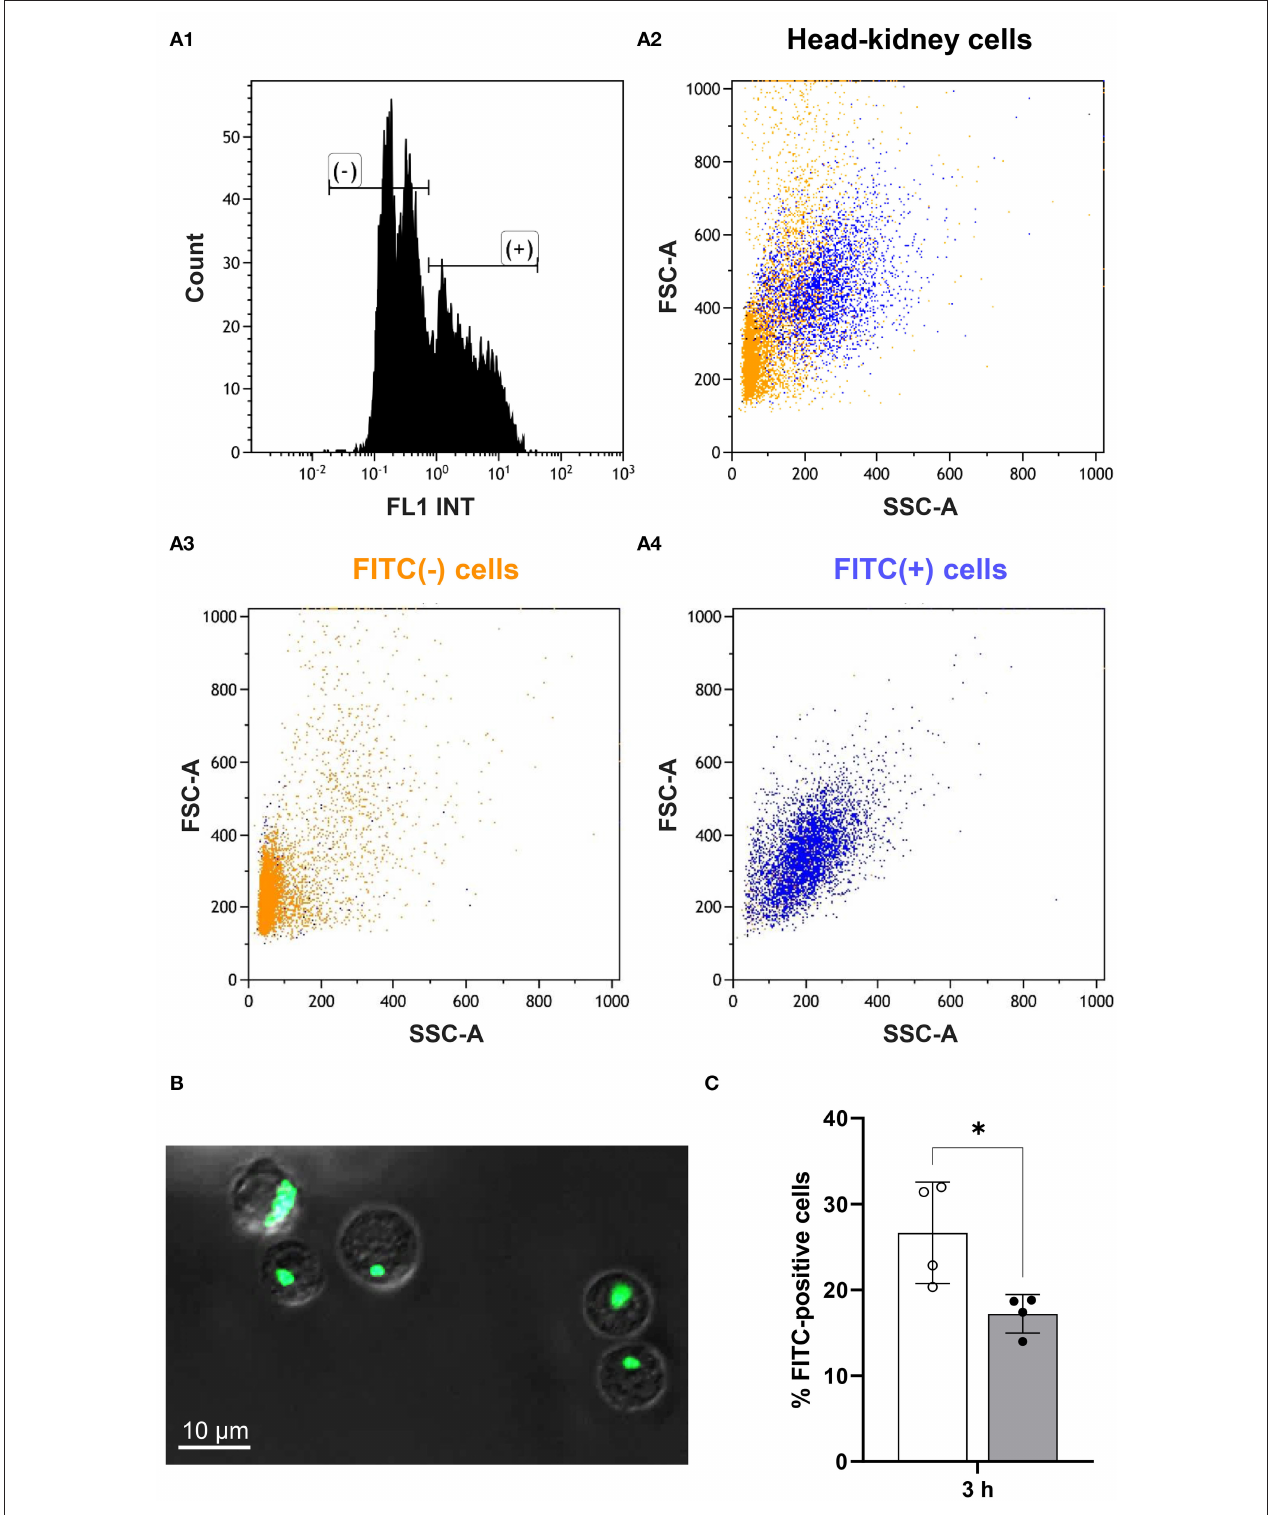
FIGURE 5 | Phagocytic capacity of myeloid cells from treated and control maraena whitefish. Sorted myeloid cells were incubated with FITC-labeled Aeromonas salmonicida . A high-speed cell sorter separated and quantified the FITC-positive and FITC-negative cells. (A1) The histogram shows the quantitative distribution of FITC-positive ( + ) and FITC-negative (–) cells. (A2–4) The FSC-A/SSC dot plots illustrate the proportion of FITC ( + ) (blue cloud) and FITC (–) (orange cloud) cells. These